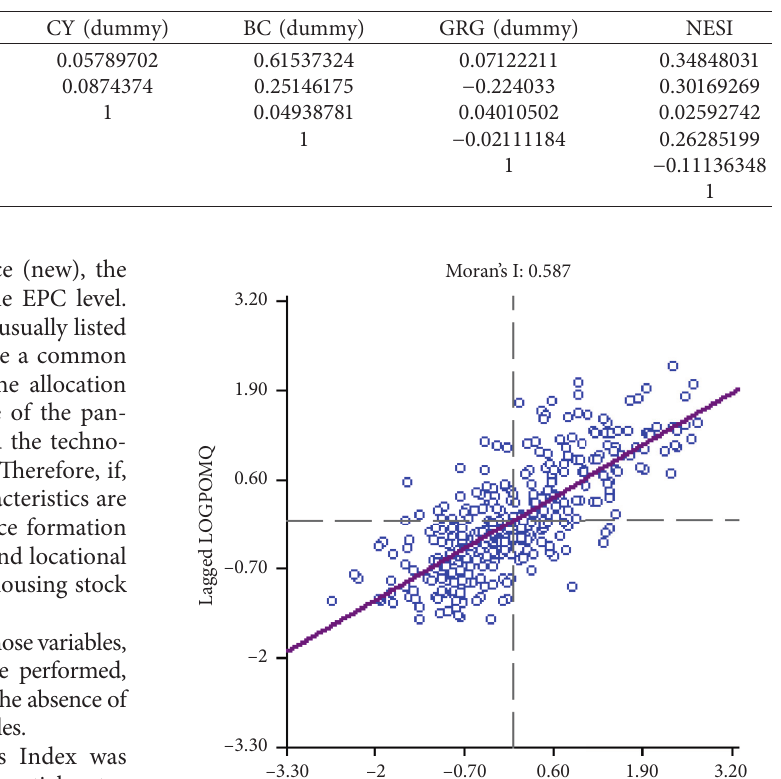
Table 3: Pearson’s Correlation Test (source: authors’ elaboration).